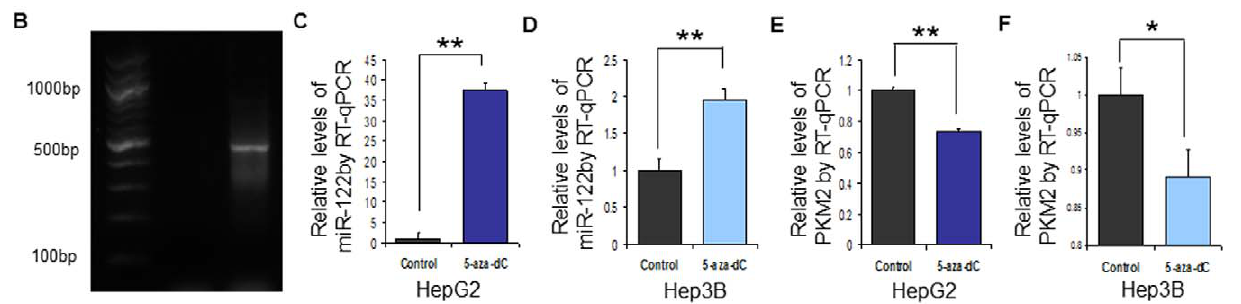
Figure 8. 5 9 RACE promoter analysis of pri-miR-122. (A) The sequence shows the promoter region of pri-miR-122 as determined by 5 9 RACE. CAAT-box and TATA box are highlighted in red, and the TSS is indicated with an arrow. The primer used to amplify the 5 9 RACE product is underlined. The DNA sequence shows chr18:54,264,000–54,265,000 (NCBI36/hg18). (B) The primer used to determine the promoter region of pri-miR-122 using 5 9 RACE. (C,F) Relative expression of miR-122 after treating the HepG2 and Hep3B cells with 5-Aza-2 9 Deoxycytidine for 3 days. n=3; error bars represent s.e.m. Student’s t-test results are indicated by (*) P , 0.05 and (**) P , 0.01 relative to the control. (F,G) Relative expression of Pkm2 after treating the HepG2 and Hep3B cells with 5-Aza-2 9 Deoxycytidine for 3 days. n=3; error bars represent s.e.m. Student’s t-test results are indicated by (*) P , 0.05 and (**) P , 0.01 relative to the untreated control. (H) Images of HepG2 and Hep3B cells 3 days after treatment with 5-Aza-2 9 -